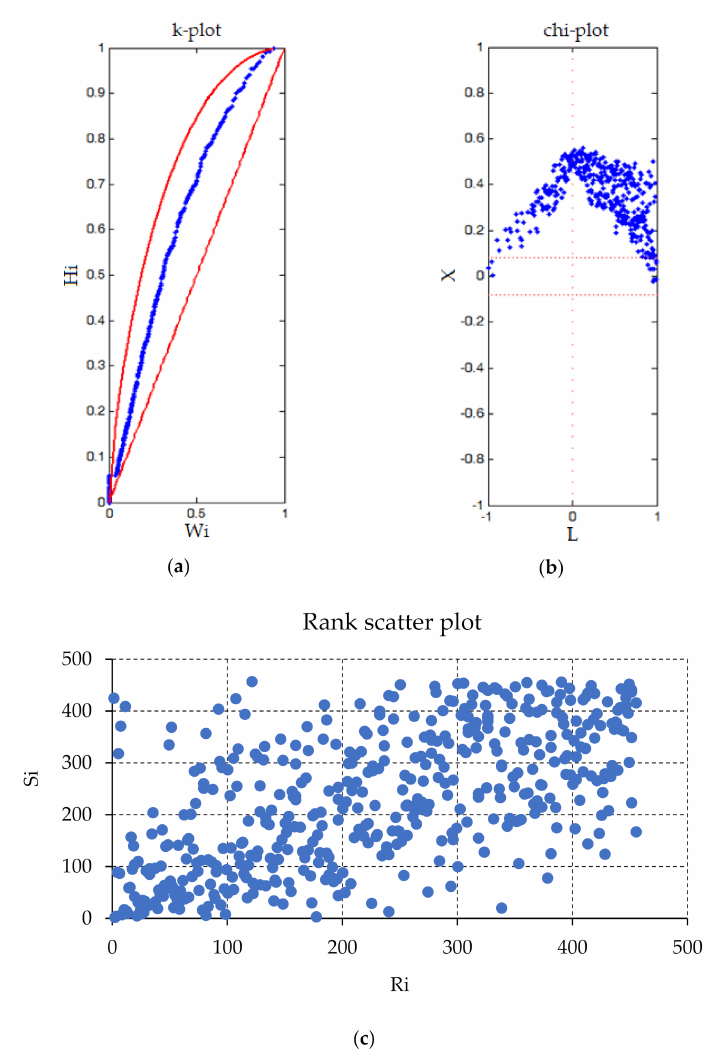
Figure 4. Dependence of monthly rainfall and runo ff data for the Rasht Basin using: ( a ) K-plot; ( b ) chi-plot; and ( c ) rank scatter